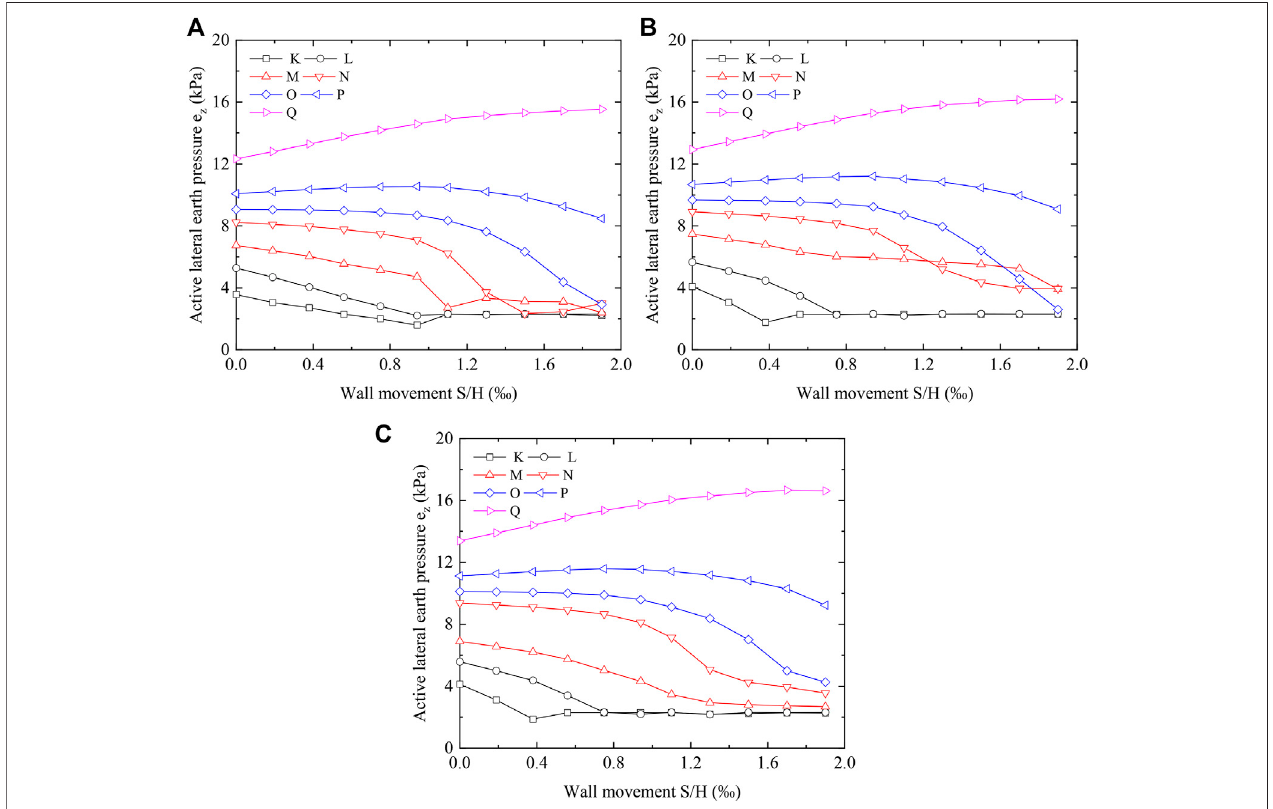
FIGURE16| ActiveLateralEarthPressureFiniteElementModelingwithRetainingWallDisplacementinRBDisplacementMode. (A) β =40 ° . (B) β =50 ° . (C) β =60 ° .